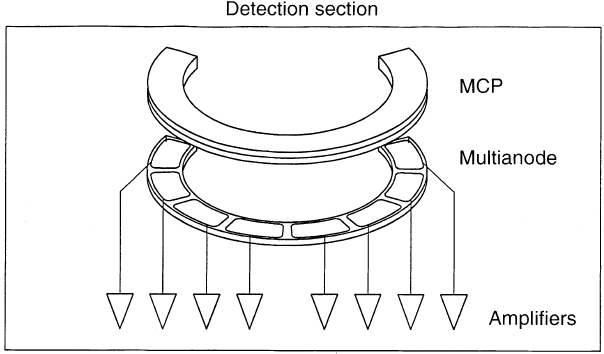
Fig. 2. Schematic view of the MCPs located at the output of the analyser and of the sectored anode which allows the discrimination of eight directions covering 180